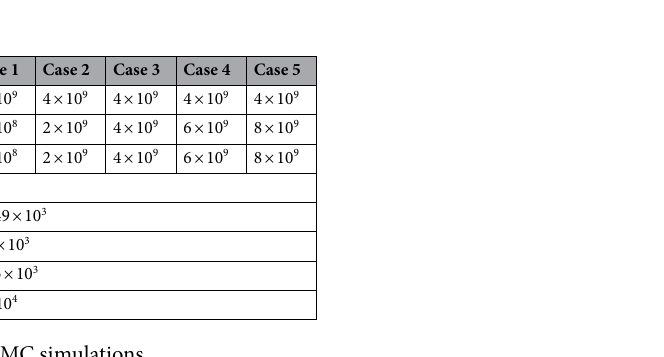
Table 4. Parameters used in DSMC